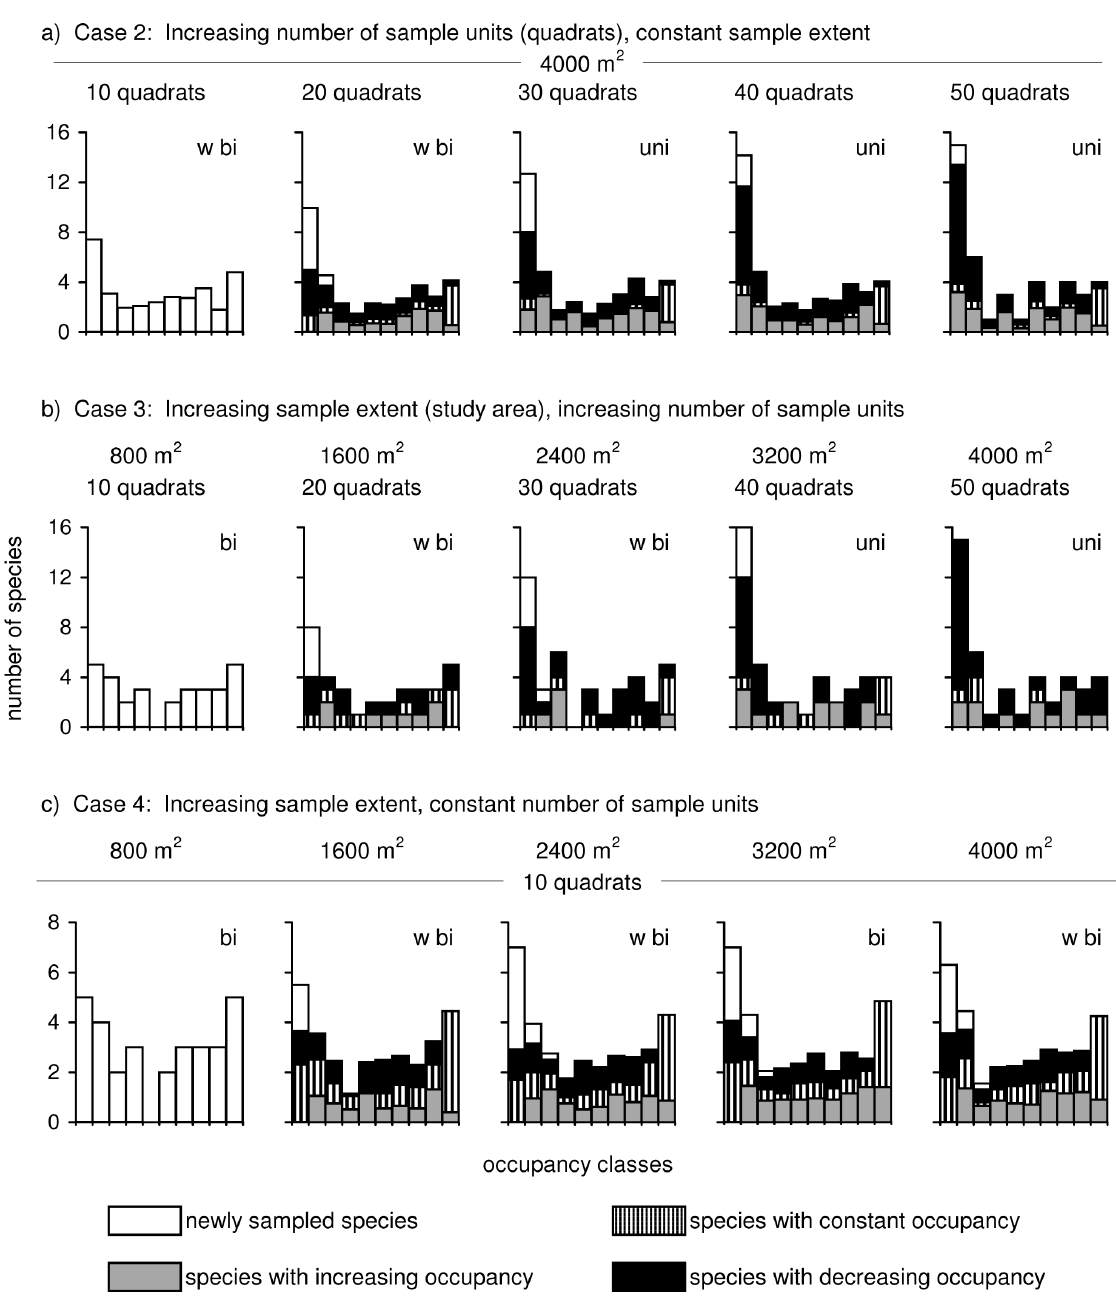
Figure 3. Shifting of species between occupancy classes as a function of increasing number of sample units (a and b) and increasing sample extent (b and c) in a meadow dominated by Bromus erectus . Species presences were sampled in regularly spaced 0.25 m 2 quad- rats. For a), 10, 20, 30, or 40 quadrats were randomly selected out of the 50 quadrats available and species occupancy of each selection was computed. This procedure was repeated 20 times and mean number of species per occupancy class are depicted in the occupancy distribution diagrams. For b), all quadrats lying within each sample extent were recorded. For c), ten quadrats were randomly selected out of the 20, 30, 40, or 50 quadrats available (depending on sample extent) and species occupancy of each selection was computed. This procedure was repeated 20 times and mean number of species per occupancy class are depicted. Determination of the shape of the occupancy distributions and the significance of modes were calculated using the test procedure of Tokeshi (1992). For legend see Fig. 1, in addition, ‘species with decreasing occupancy’ belonged to a higher occupancy class in the next smaller sample number or sample extent,